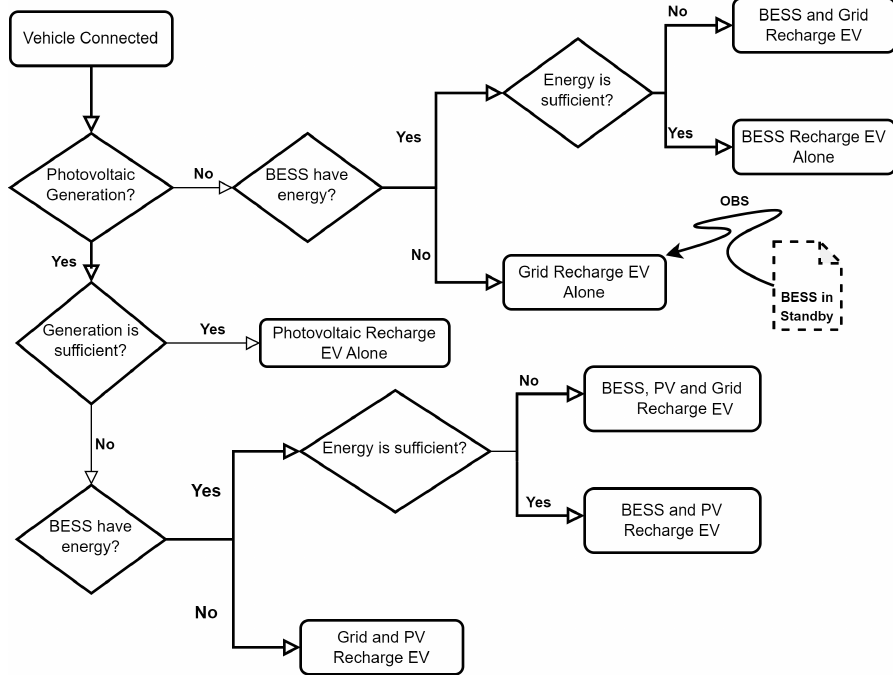
Figure 3. Fluxogram of